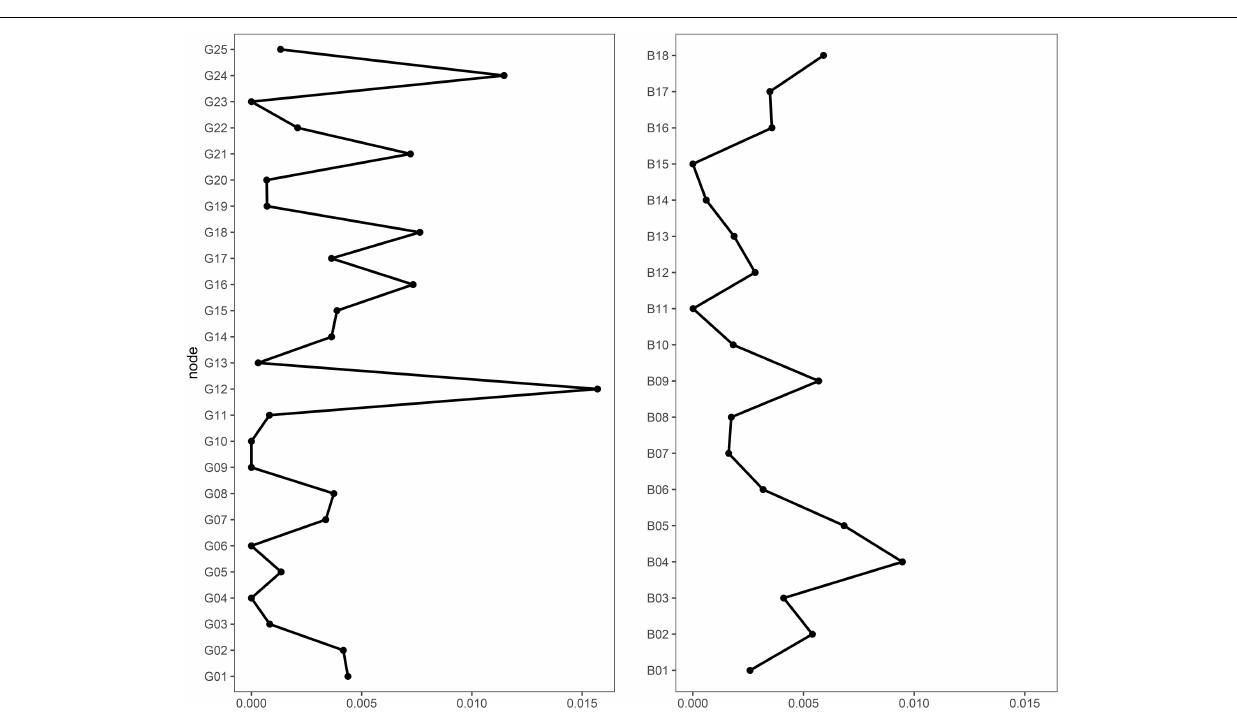
Frontiers in Psychology |